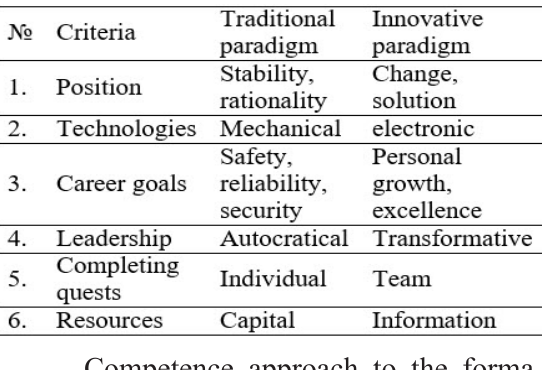
Table 1. Changing of traditional profes- sional paradigm to the innovative paradigm in the modernization of